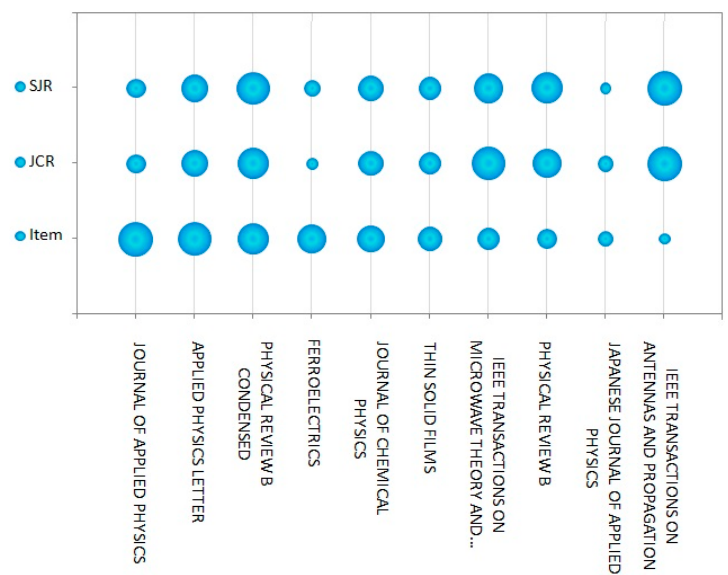
Figure 10. Ranking of top 10 dielectric journals according to items, JCR (Journal Citation Reports) and SJR (Scientific Journal Rankings) criteria.